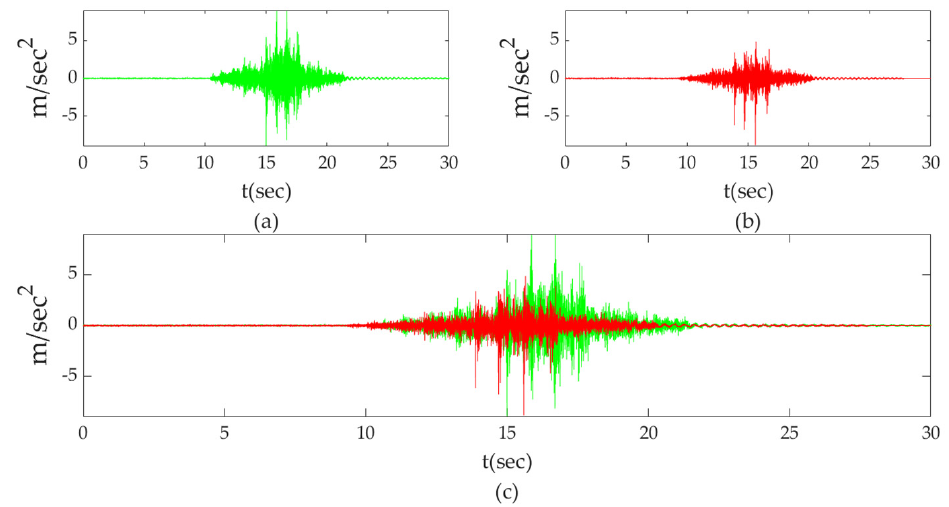
Figure 26. Measurement’s comparison of sensors 2 and 5 for Veh6; ( a ) sensor 2; ( b ) sensor 5; ( c ) sensor 2 vs. sensor 5.